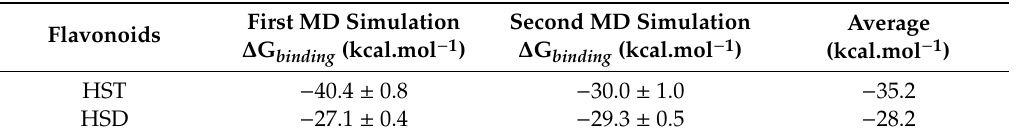
Table 2. Theoretical binding free energy ( ∆ G binding ) determined by MM-PBSA calculations for the structural models of the M 2-1 / flavonoid complexes using the last 10 ns MD trajectories.